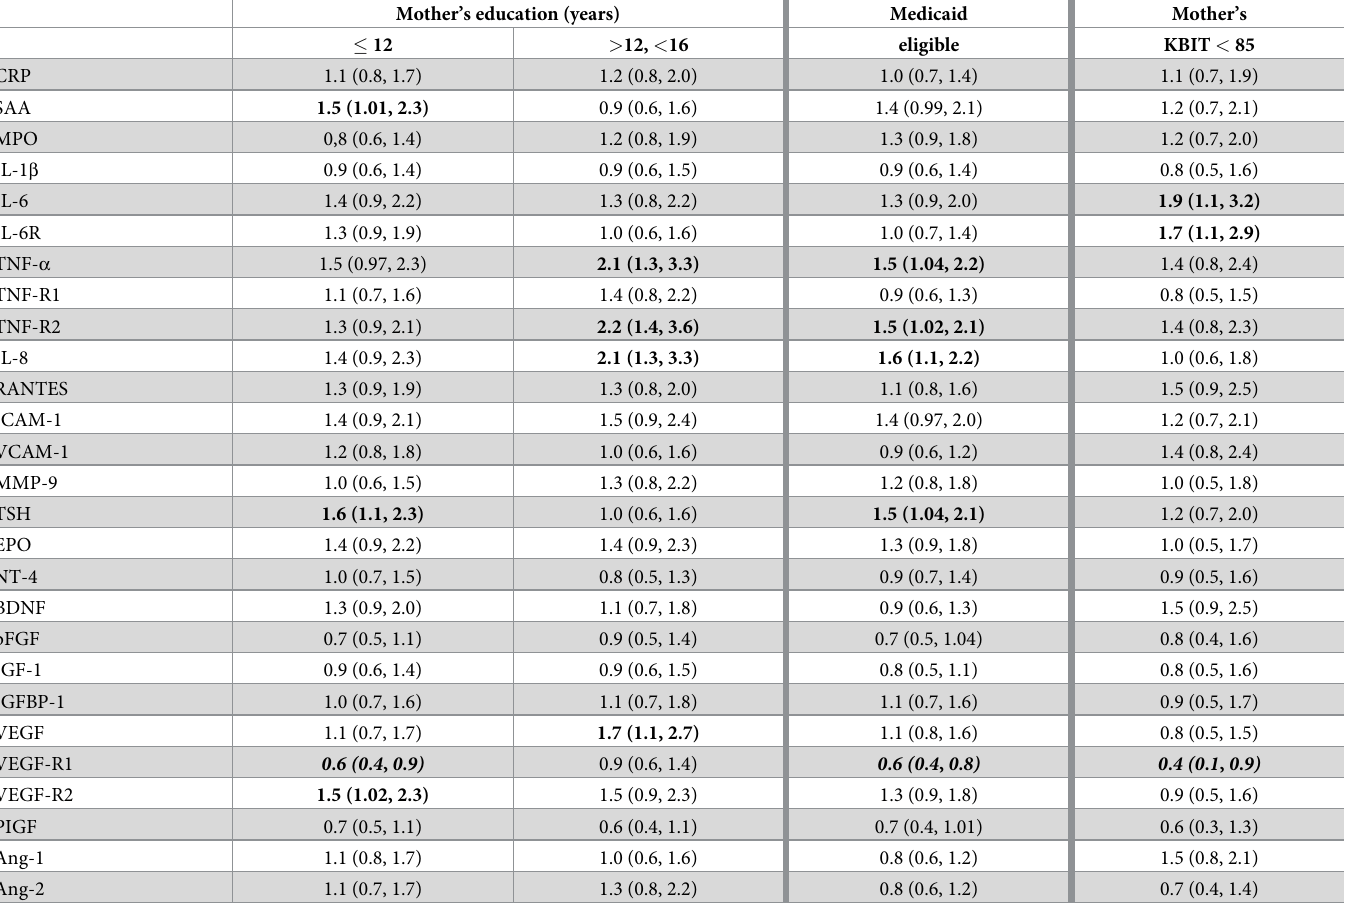
Table 2. Odds ratios (95% confidence intervals) for a top-quartile concentration of the protein listed on the left on 2 days during the early epoch among children whose mother had the characteristic listed at the top of the column relative to the risk among children who did not have that characteristic. The referent group for the 2 maternal education characteristics is comprised of children whose mother had the equivalent of a college education. Adjustment is made for gestational age category and birth weight Z-score < -1. Bold indicates odds ratios significantly > 1 (p < 0.05) and bold italic indicates odds ratios significantly < 1 (p <